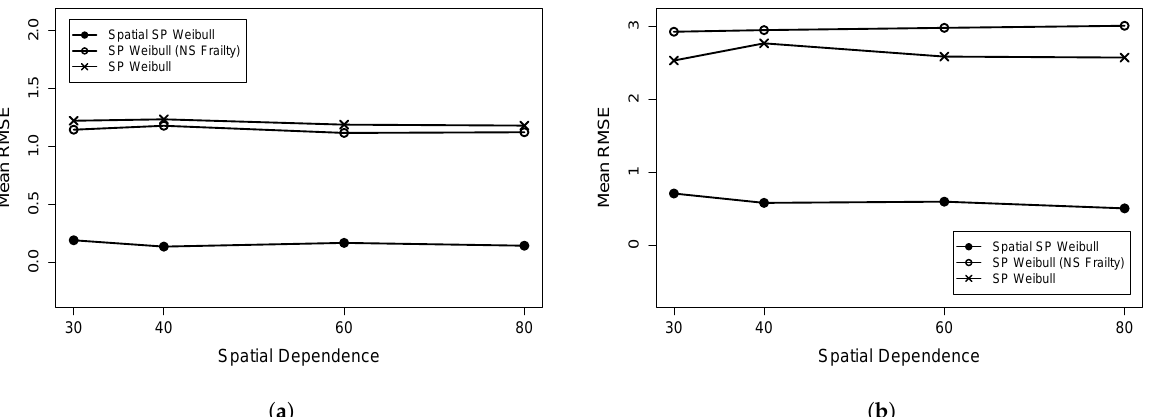
Figure 2. MC Experiment 2 mean RMSE comparison between SP Weibull, NS Frailty SP Weibull, and spatial SP Weibull models for ( a ) ˆ β coefficients and ( b ) ˆ γ coefficients with spatial dependence changing from 30% to 80% of the